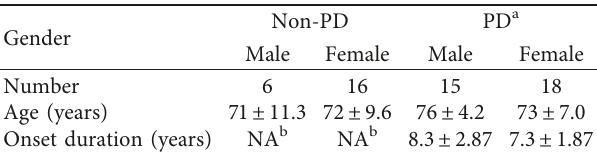
Table 2: Summary of patient